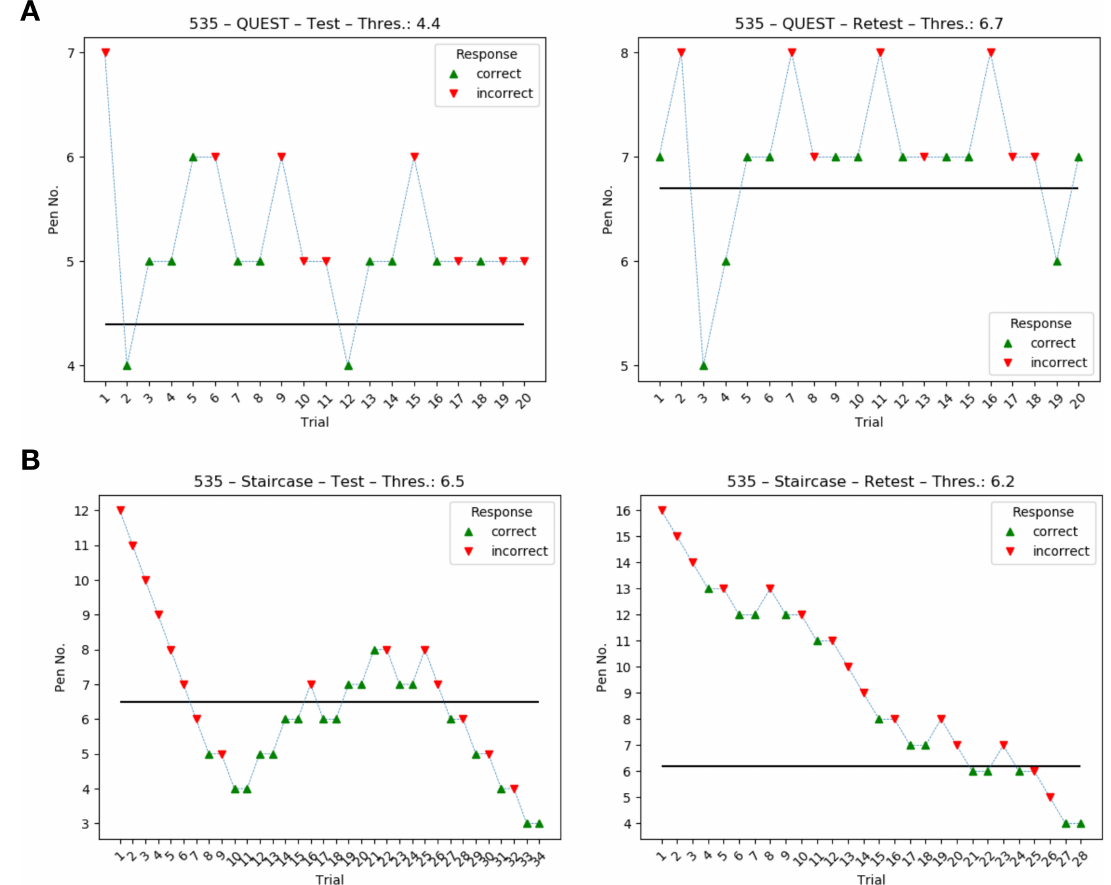
Figure A1. Comparison of threshold estimation runs of the same participant during test and retest sessions for QUEST ( A ) and the staircase ( B